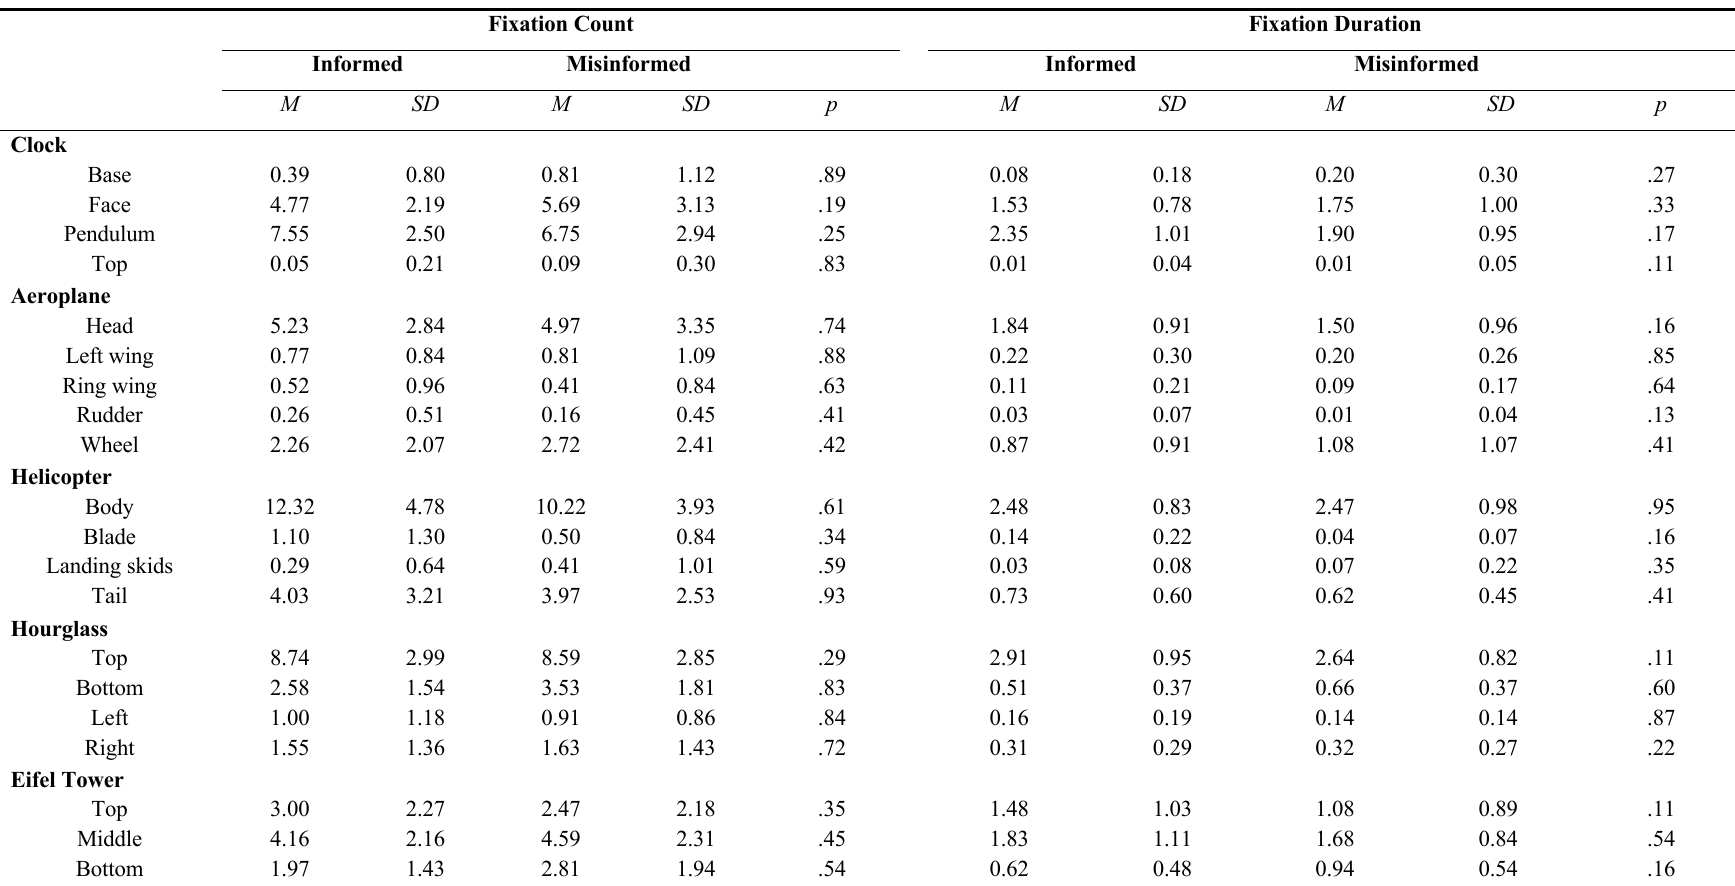
Mean fixation count and mean fixation duration (with standard deviation) for each AOI within different inanimate objects. All p values reveal no significant difference between informed and misinformed groups (at p